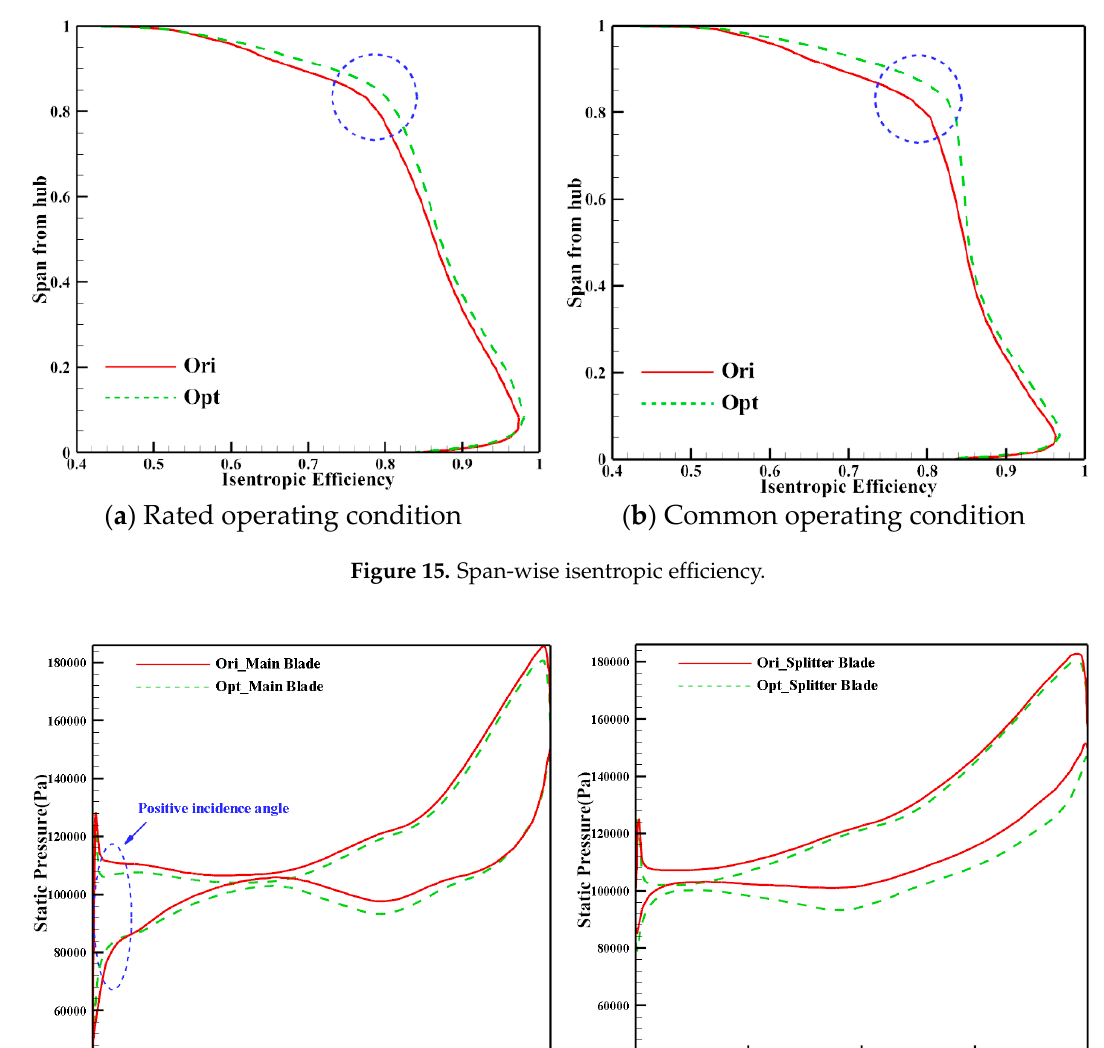
Figure 15. Span ‐ wise isentropic efficiency.